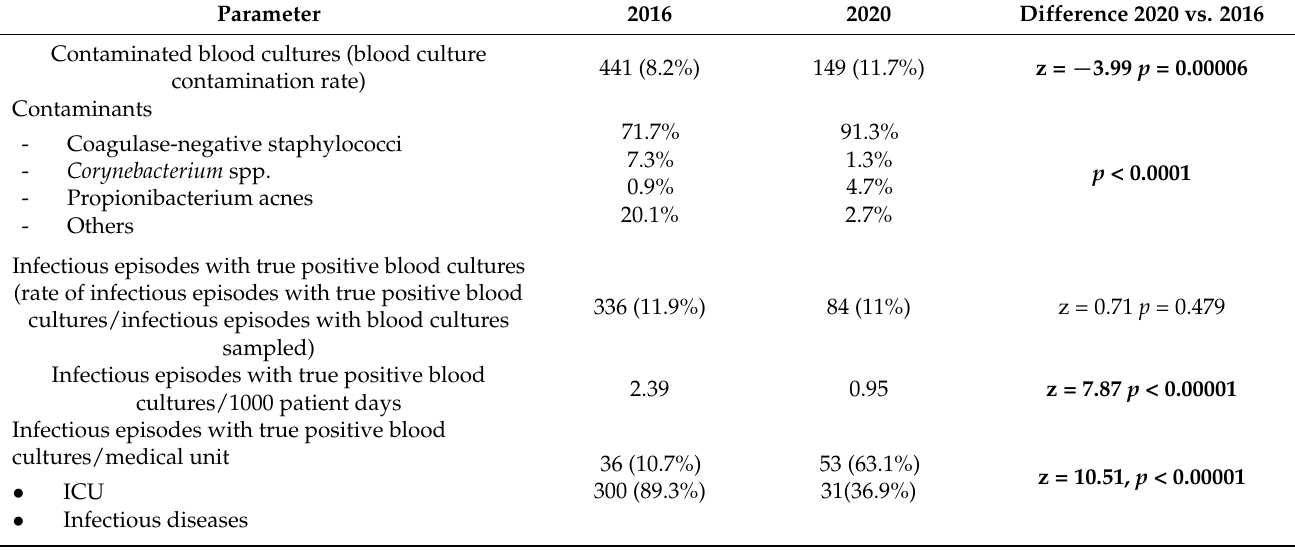
Table 3. Positive blood culture isolates, true positives, and contaminants: 2020 versus 2016.